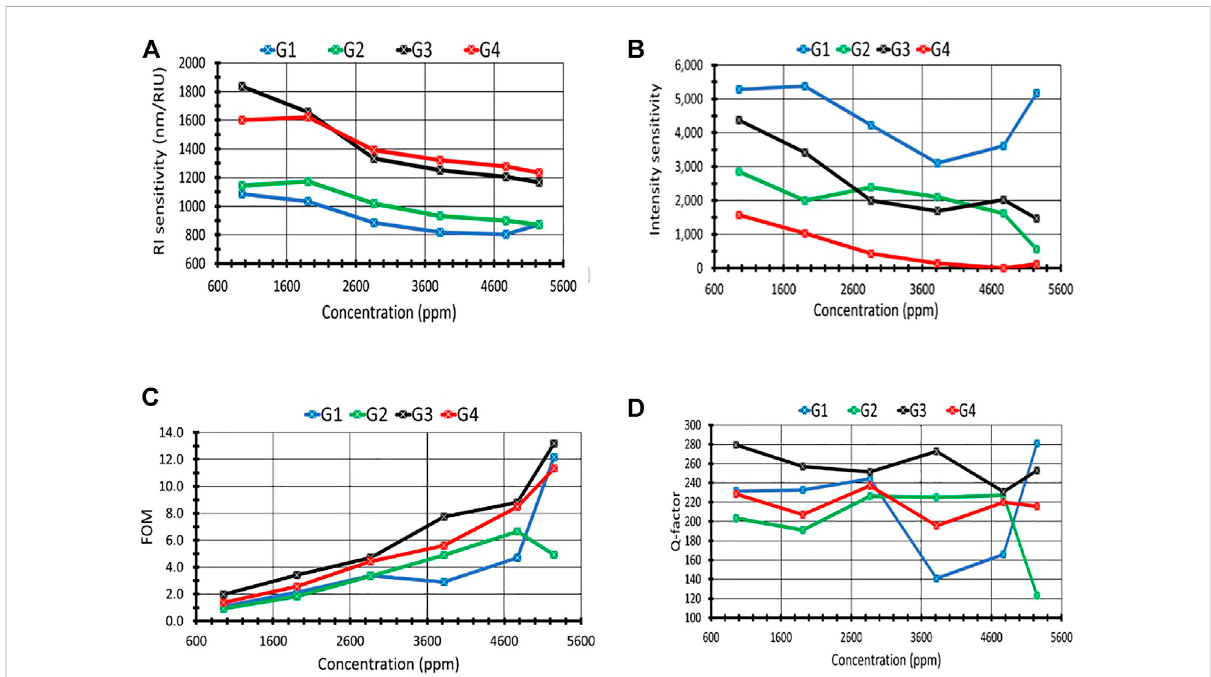
FIGURE 8 (A) Effectofconcentration ontherefractiveindexsensitivity(nm/RIU) for groupsG1,G2,G3,andG4. (B) Effectofconcentrationon theintensity sensitivity, for groups G1, G2, G3, and G4. (C) Effect of concentration on the FOM, for groups G1, G2, G3, and G4. (D) Effect of concentration on the Q-factor, for groups G1, G2, G3, and G4.